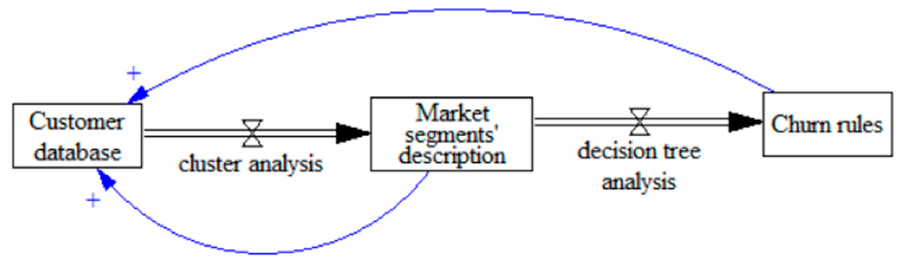
Figure 6. The continuous process of churn management. Source: authors’ work, 2021.